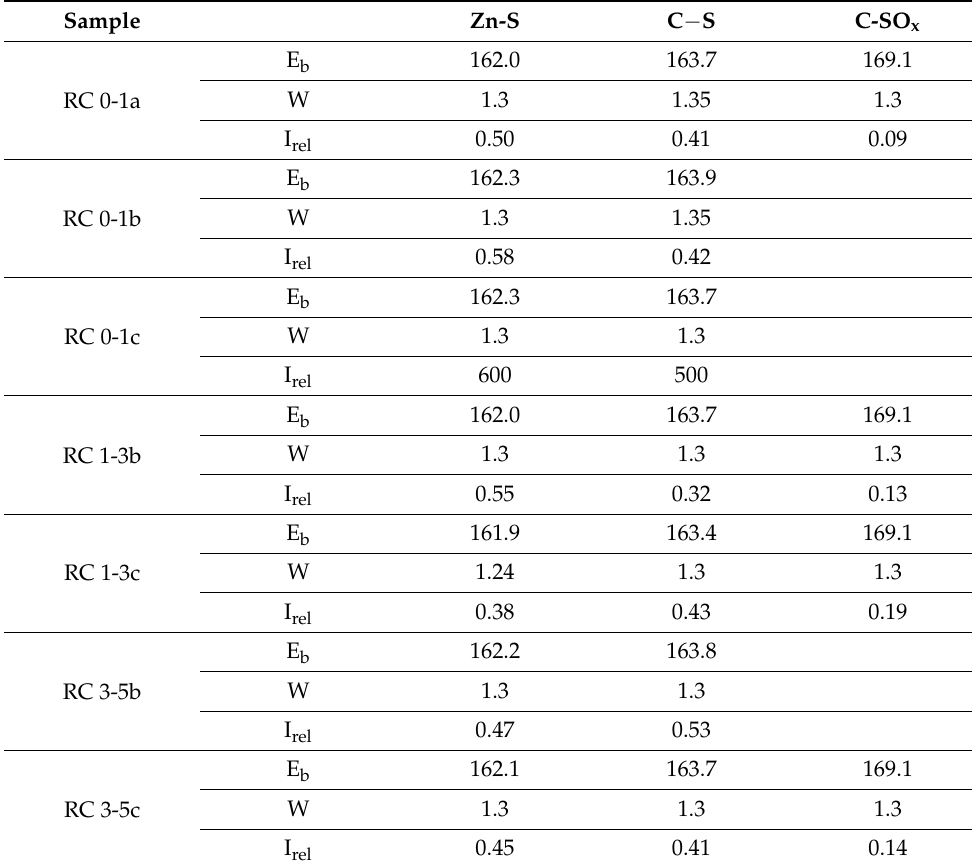
Table 4. Parameters of components in S 2p 3/2 photoelectron spectra of rubber crumbs: E b —binding energy, W—peak width, and I rel —relative